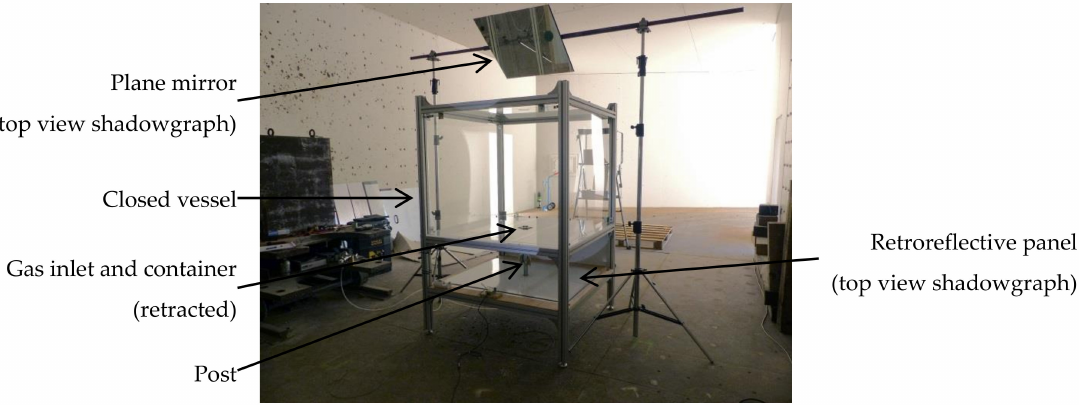
Figure 1. Global view of the experimental setup. The retro-reflective back panel was removed when the picture was